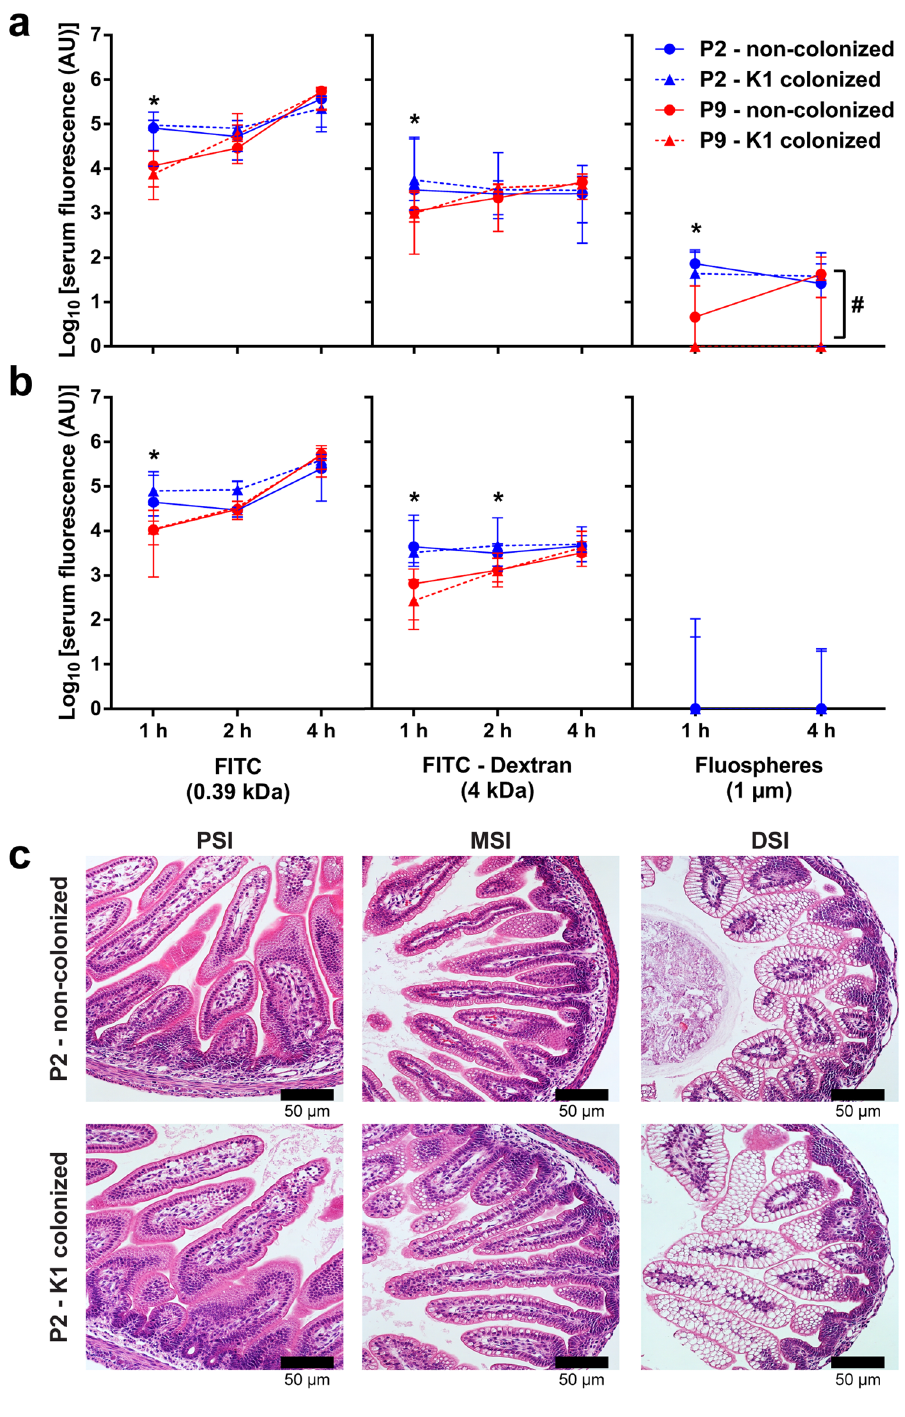
Figure 2. Colonization with E. coli K1 does not alter the integrity of the intestinal epithelium. Age dependency of intestinal permeability in non-colonized P2 and P9 pups 24 h ( a ) and 48 h ( b ) after E. coli A192PP colonization or sham colonization (broth vehicle alone); plasma fluorescence was determined at indicated time points after oral administration. In addition, neonatal rats were colonized at P2 or P9, fluorescent probes administered orally 24 h or 48 h later and plasma fluorescence determined. Plasma fluorescence was expressed as log 10 relative fluorescence units (RFU). ( c ) Micrographs of H&E stained PSI, MSI and DSI tissue obtained from neonates 48 h after sham (non-colonized) or A192PP (K1-colonized) feeding at P2. In all experiments, n = 6–8 animals; median ± range, n.s., not significant, * P < 0.05, ** P < 0.01 (Student’s t ). # Indicates significant difference between sham-colonized and E. coli A192PP-colonized